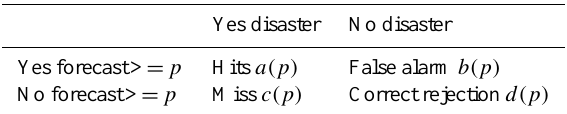
Table 2. Contingency table based on a forecast threshold of p to trigger action.